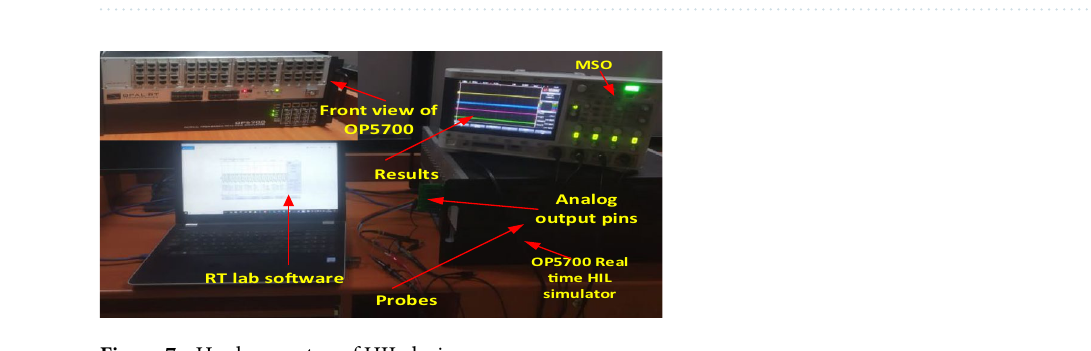
Figure 6. ( a ) Pump performance curve and system curve in healthy condition ( b ) Pump performance curve and system curve in 40% inter-turn fault condition.